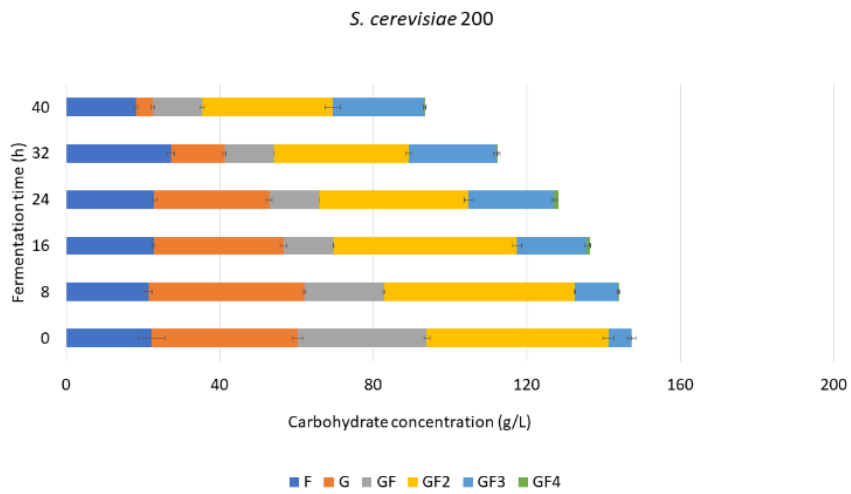
Figure 5. Carbohydrate concentration during successive fermentation with Saccharomyces cerevisiae 200 on AgMe fermentation mixture. 200 on AgMe fermentation